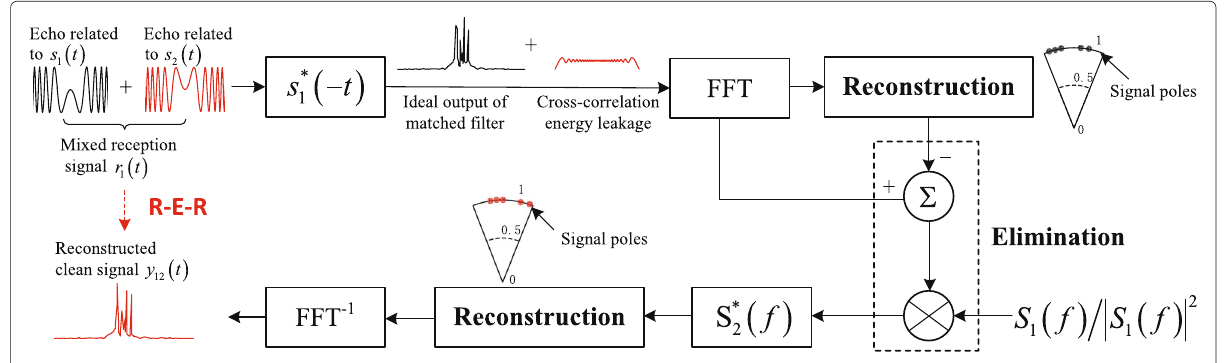
Fig. 2 R-E-R framework for dual radar